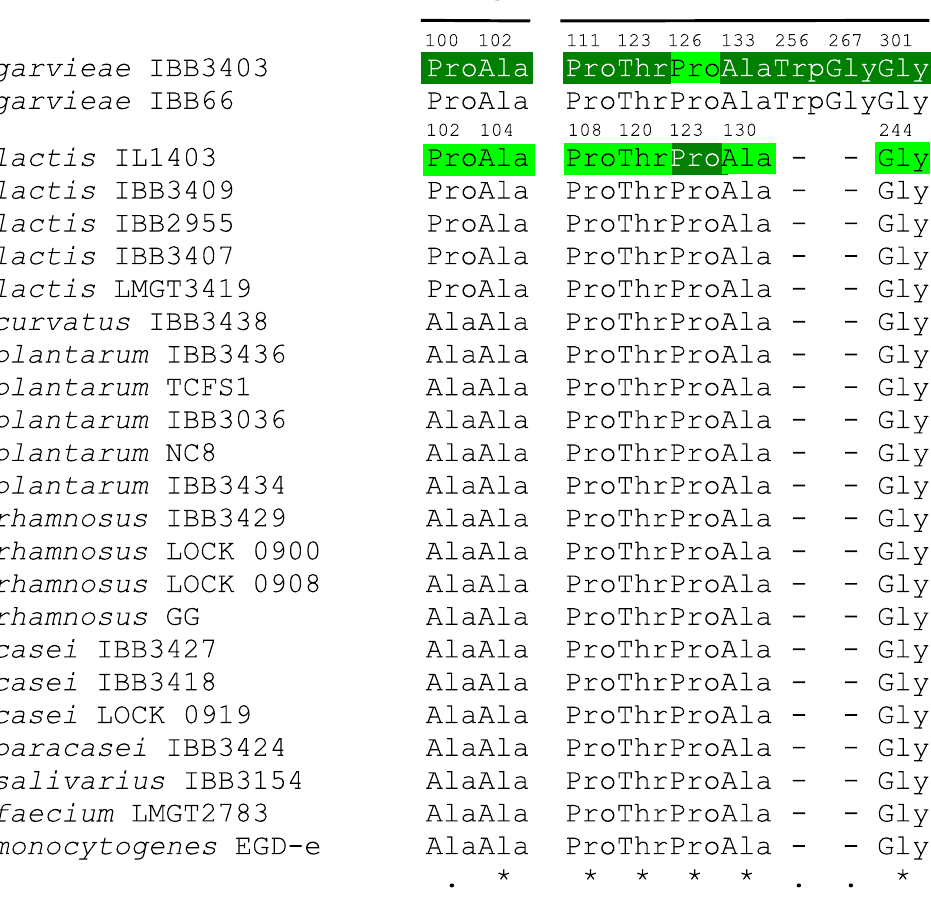
Selection of L . garvieae IBB3403 GarQ-resistant mutants. To identify genes involved in the sensi- tivity to GarQ in target cells that could encode a GarQ receptor, we isolated resistant mutants of the highly sen- sitive strain L . garvieae IBB3403 by exposing the cells to increasing concentrations of GarQ on BHI-agar plates. Twenty-one independent spontaneous GarQ-resistant mutants were obtained at GarQ concentration of 1 mg/ml (mutants PW200 - PW220; Table 2). All these mutants were equally resistant to GarQ with the MIC value over 1024-fold higher than that of the parental L . garvieae IBB3403 (MIC = 0.098 µ g/ml). After multiple passages with- out selective pressure of GarQ, no loss of resistance was observed indicating that the resistance was due to stable genetic mutations rather than an adaptation event. GarQ-resistant mutants contain mutations in genes encoding Man-PTS. In order to identify the mutations in the genomes of the GarQ-resistant L . garvieae IBB3403 strains, DNA was isolated from nine ran- domly selected spontaneous mutants (PW200 - PW205, PW207, PW209 and PW210), sequenced and compared with the genome of parental GarQ-sensitive L . garvieae IBB3403. Single mutations were detected exclusively in the manABCD operon encoding Man-PTS (Table 2). Encouraged by this result, we performed direct sequencing of the manABCD operon in the remaining twelve GarQ-resistant mutants using specific primers. Altogether, among the twenty-one sequenced mutants, twelve harbored mutations in the manC gene encoding the IIC subu- nit, while the remaining nine mutants contained mutations in the manD gene coding for the IID subunit (Table 2). No mutation was found in the manAB gene encoding the cytoplasmic Man-PTS IIAB component, suggesting that this component is likely not required for the sensitivity to GarQ. The manCD mutations were of different types. Most caused premature truncation of the IIC or IID polypeptides, due to either nonsense or frameshift mutations in the manC or manD genes, and only three were missense mutations. Remarkably, in all three missense mutants the substituted amino acids were in the predicted outer regions of the transmembrane subunits IIC or IID. The